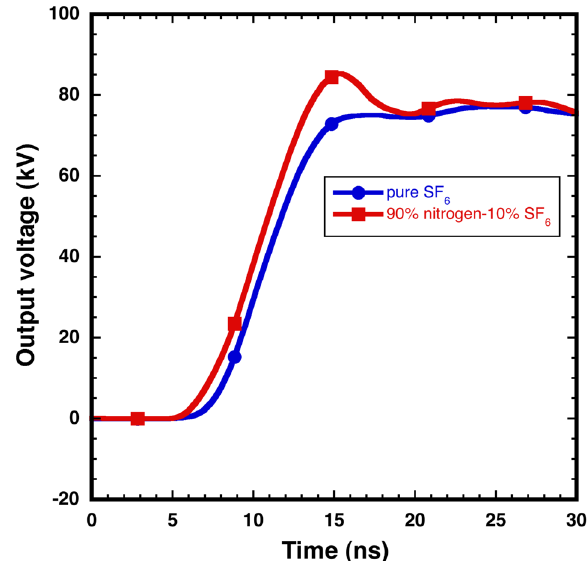
FIG. 5. (Color) Logarithmic plot of calculated prefire probabil- ity versus fraction of median self-break voltage at 432 kPa, with 7 mm gaps, calculated from a largest extreme value fit to the measured self-break data. By definition, the breakdown proba- bility at the median self-break voltage is 0.5.